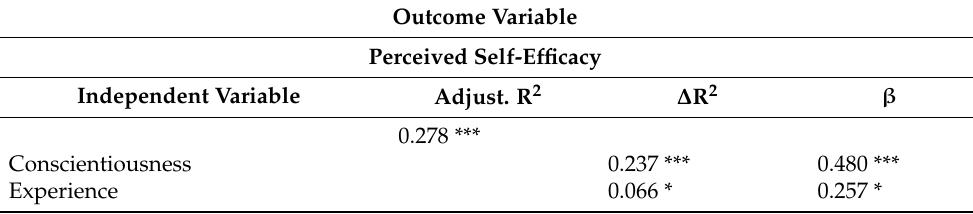
Table 6. Results of Hierarchical Linear Regression Analyses of Clown Therapists working with the